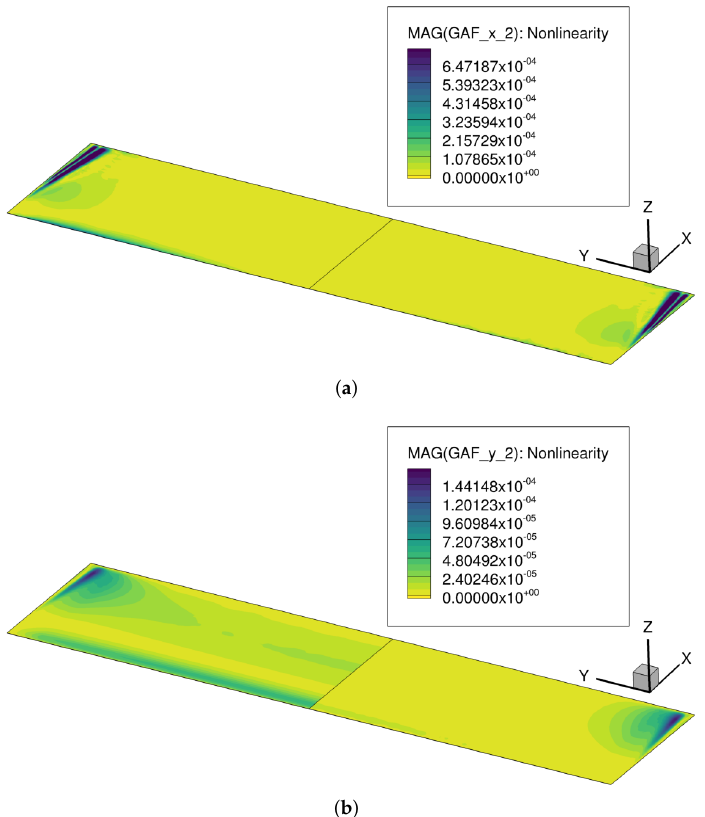
Figure 16. Spatial locations of nonlinear components of Q hh ( 2,1 ) (viscous flow, Mach 0.4. Positive semi-span: linear modal, negative semi-span: extended modal). ( a ) Longitudinal GAF component; ( b ) lateral GAF